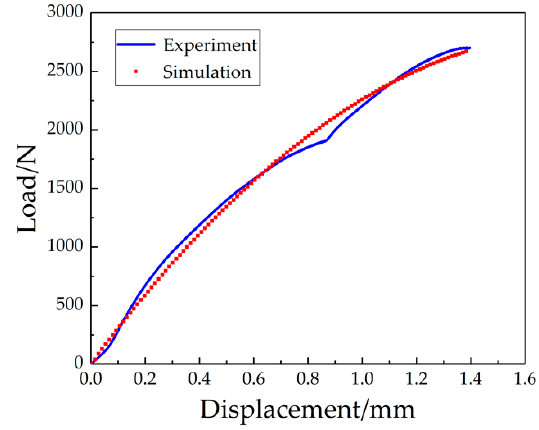
Figure 12. An experiment and simulation comparison of the L-D curve.